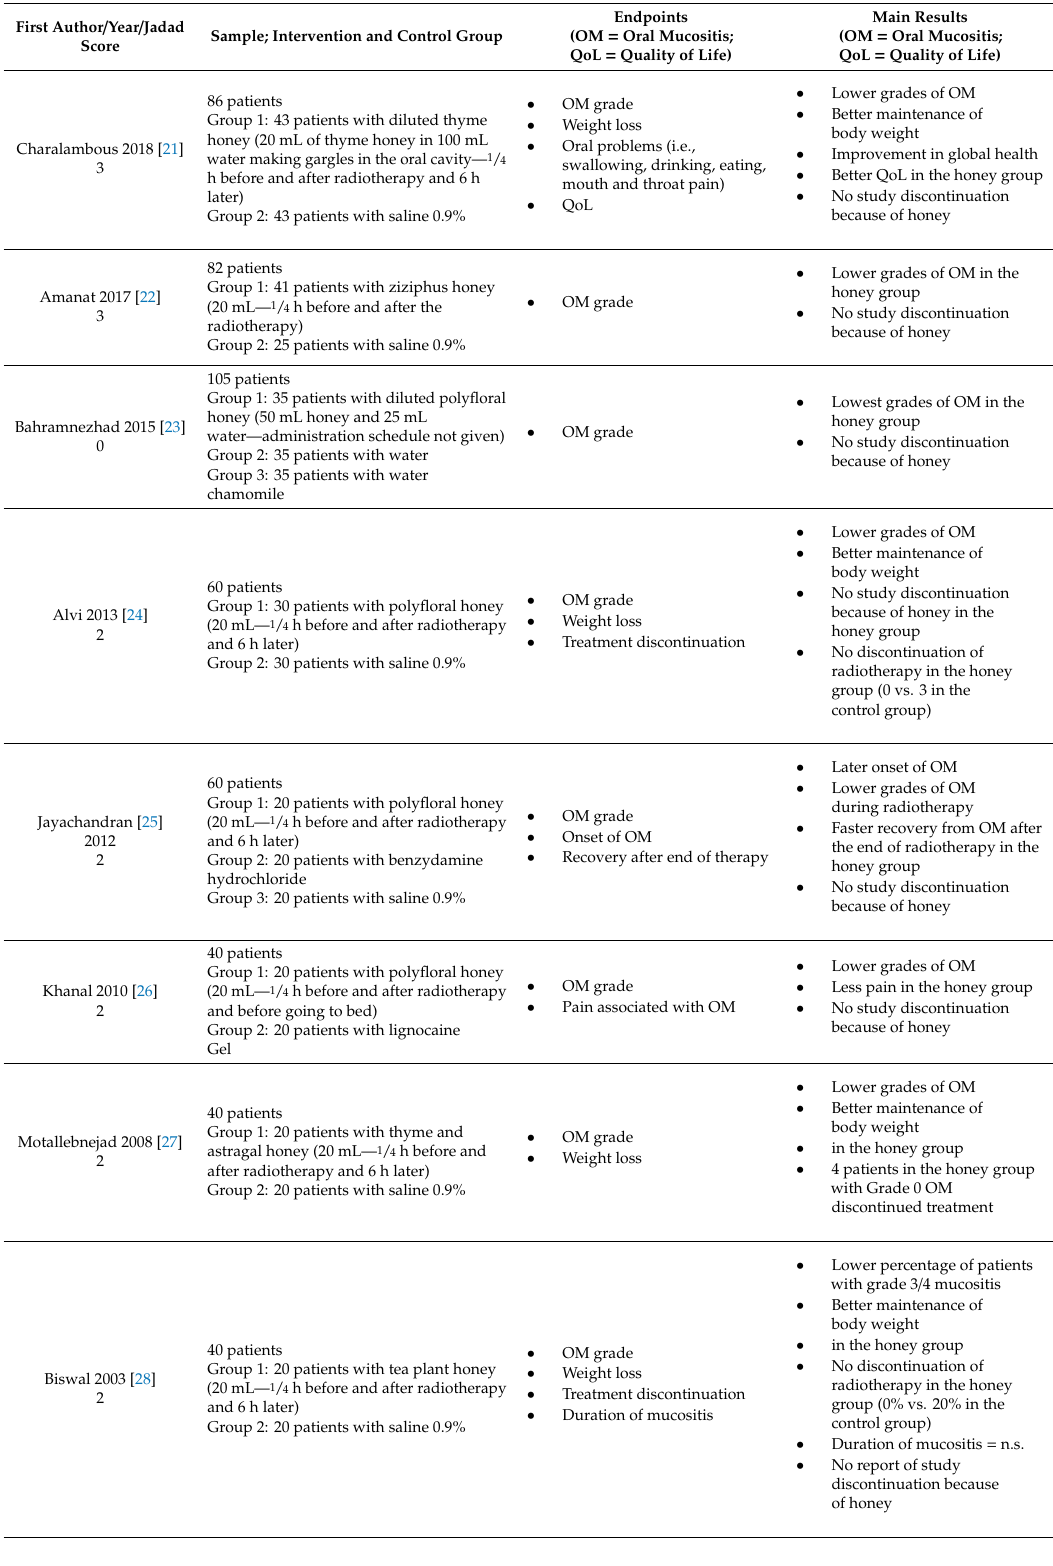
Table 1. Summary of randomized trials on honey and radiation therapy. All studies had positive results for